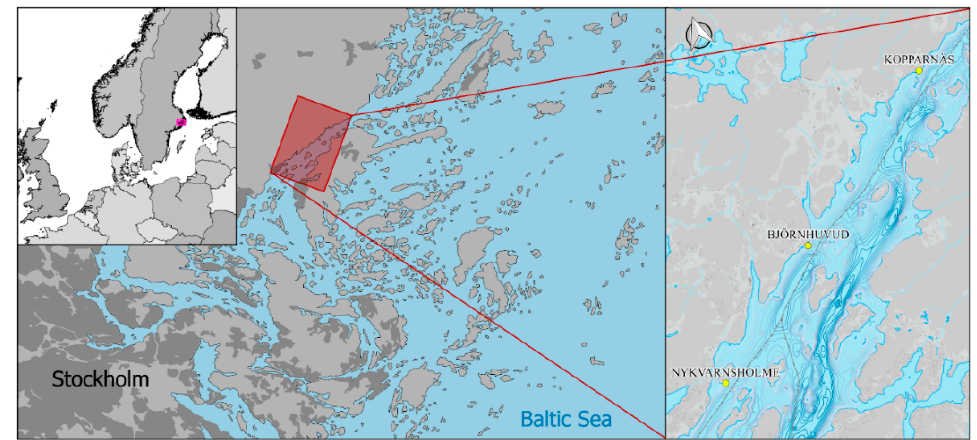
Figure 2. An overview of the Furusund fairway with the locations of ship wave measurements shown as yellow markers.